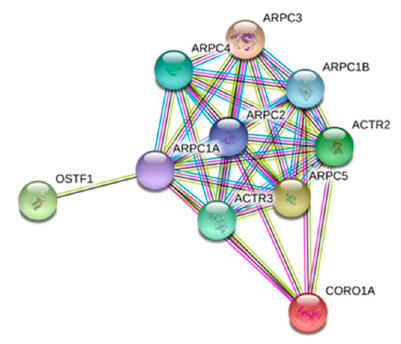
Figure 5. STRING analysis of the CORO1A interactome. Interactions among proteins found CORO1A and OSTF1, where participated ARP family proteins.